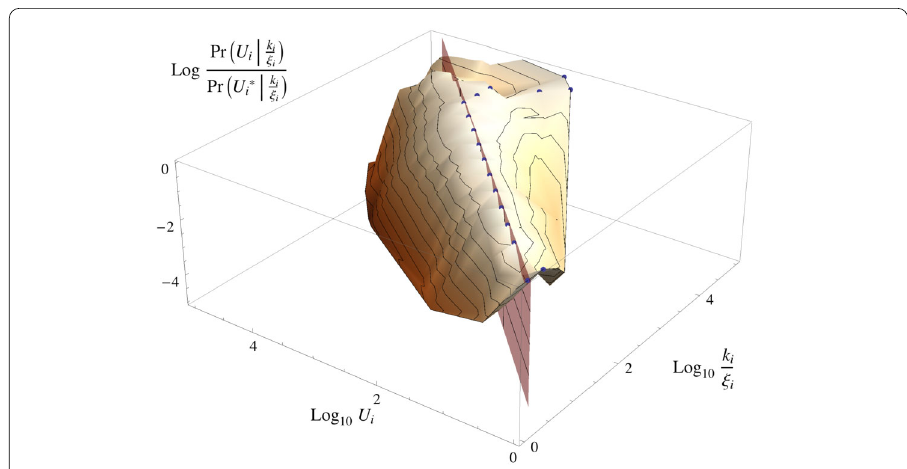
Figure 8 Behavior of log 10 [Pr( U i | k i / ξ i )/Pr( U ∗ i | k i / ξ i )] (surface S ) with respect to log 10 U i and log 10 k i / ξ i for Mexico. The data is logarithmically binned as in the same way as in Fig. 6 ( ζ = 2) with U min = min[ { U i } { i } ] (smallest firm-specific unemployment size in the data) and ( k / ξ ) min = min[ { ( k i / ξ i ) } { i } ]. Blue points represent the local maximum of S at each bin. The vertical plane P is parametrized as ( k i / ξ i , C U k i / ξ i , z ) where z is a free (cid:2) ∗ parameter. C U is chosen to minimize – C U ( k / ξ ) b ) 2 with the last five bins excluded at the point where b ( U b the linear relationship breaks down. The large range within which the intersection of P and S runs parallel to the maxima of S strongly supports Eq. (21)